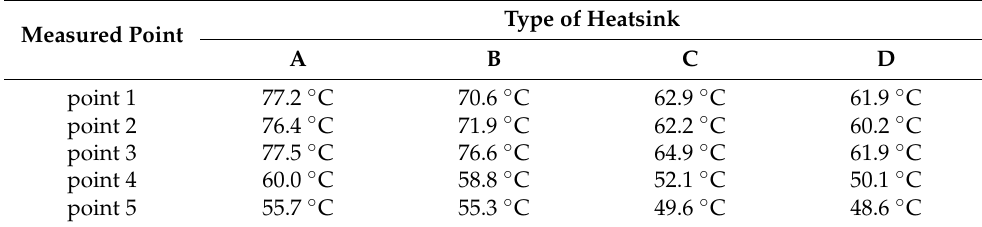
Table 4. Results of actual thermal measurement of four types of heatsink.